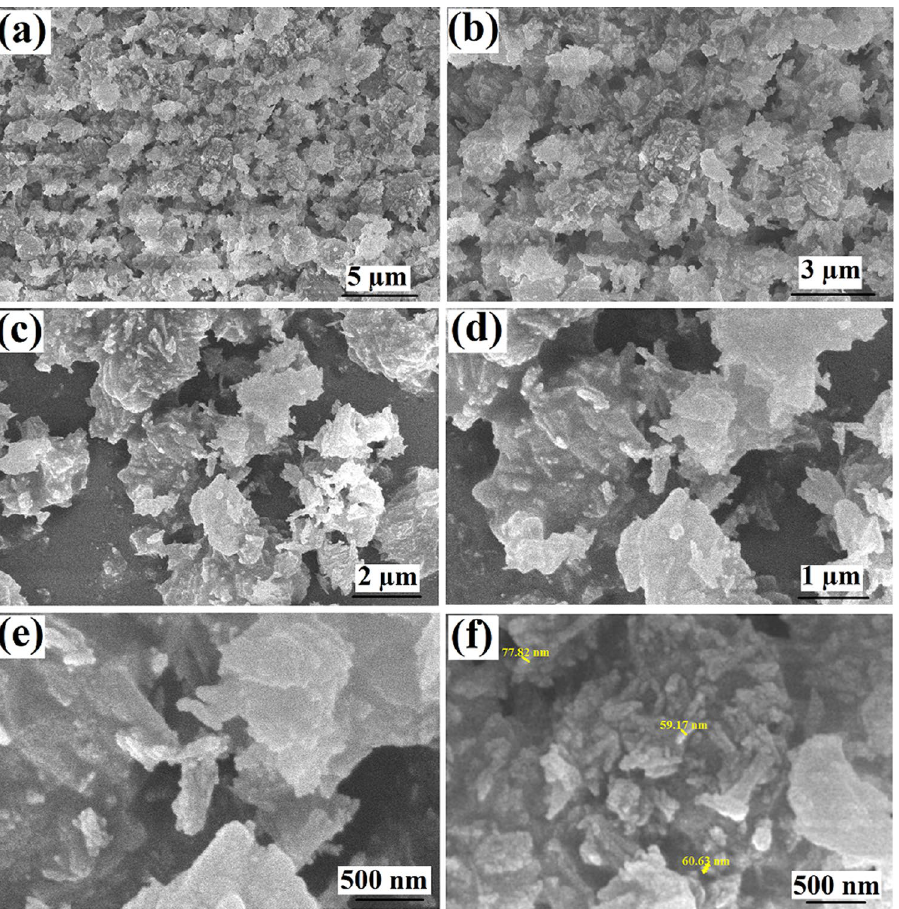
Figure 1. FESEM images of amino-MIL-68(Al) with different magnifications ( a – f